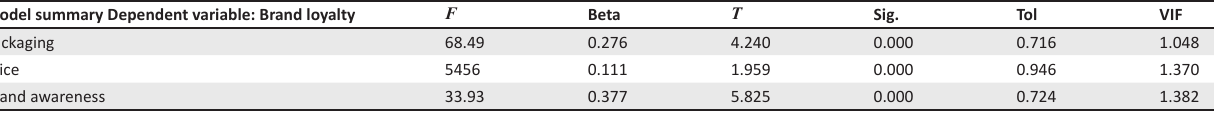
TABLE 3: Regression model summary of packaging, price, brand awareness and brand loyalty. Model summary Dependent variable: Brand loyalty